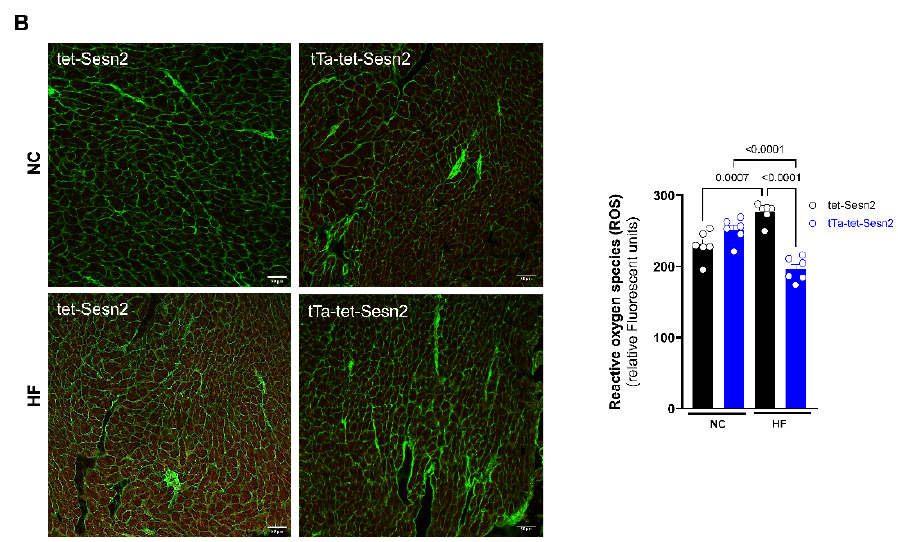
Figure 6. ROS staining results and representative images for mouse LV tissue. ( A ) Sesn2 f lox / flox and cSesn2 − / − and ( B ) tet-Sesn2 and tTa-tet-Sesn2. Means ± SE. n = 6 per group.